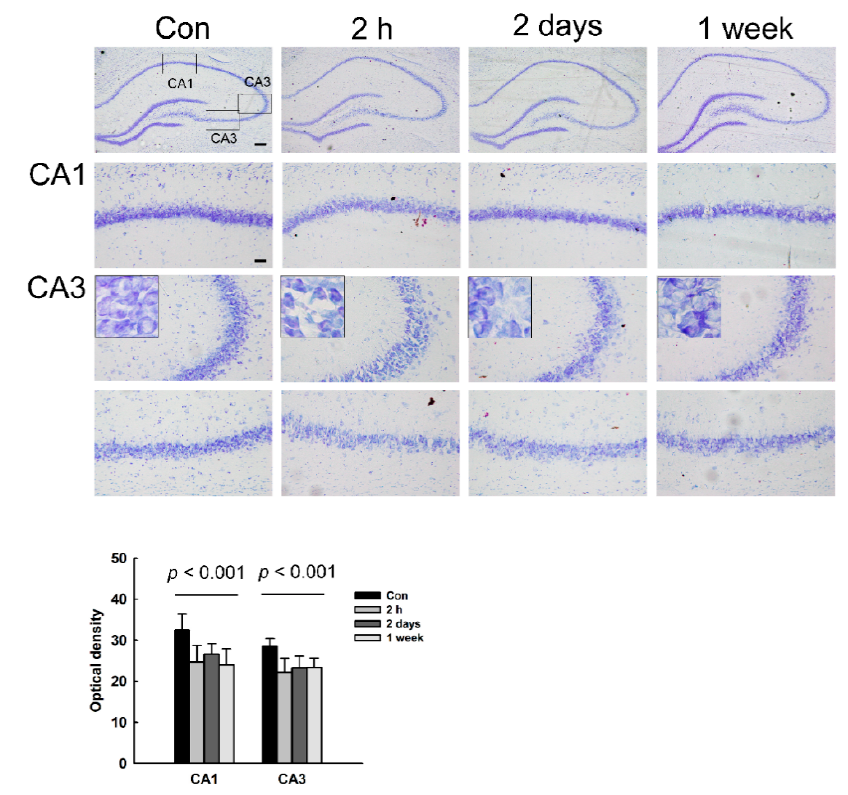
Figure 3. Neuronal cell death in the hippocampus of NMDA-treated rats. Morphological changes in the hippocampus after NMDA treatment were assessed using Nissl staining. The histogram reveals the optical density of Nissl-stained cells as the mean ± standard error of the mean (SEM). Scale bars = 200 (low magnification) or 50 µ m (high magnification).